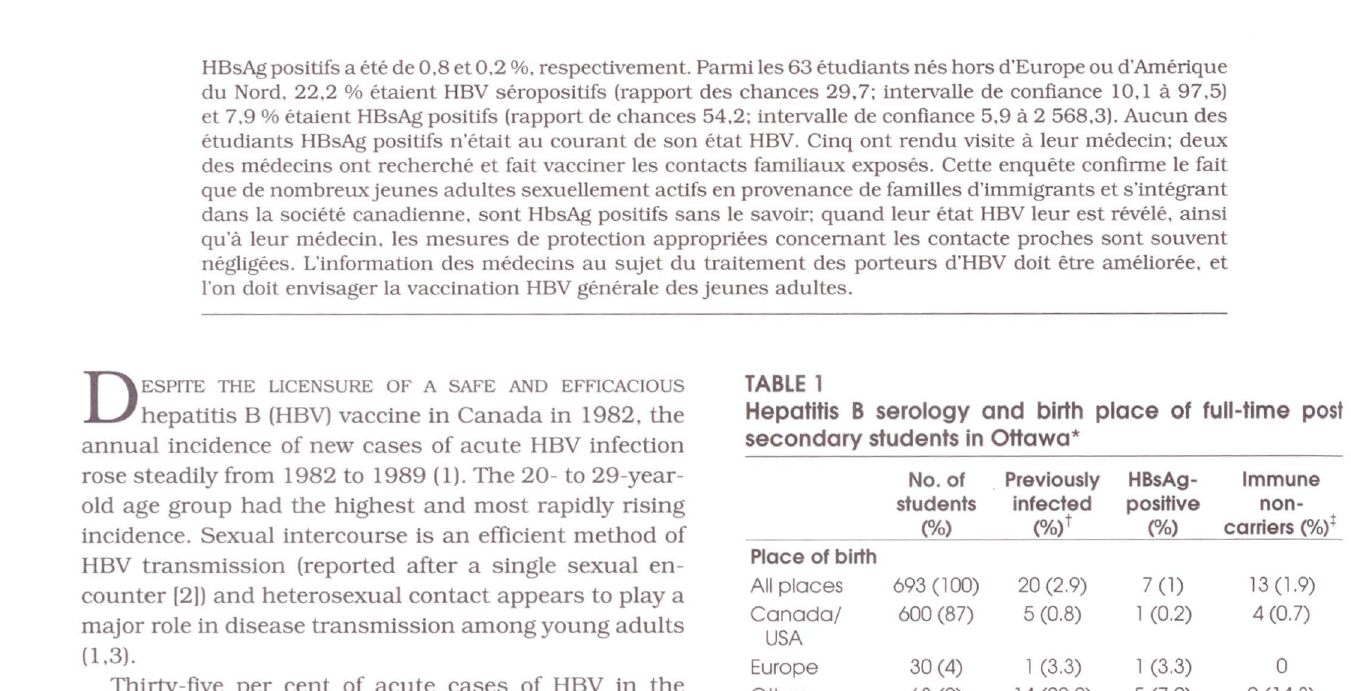
Hepatitis B serology and birth place of full-time